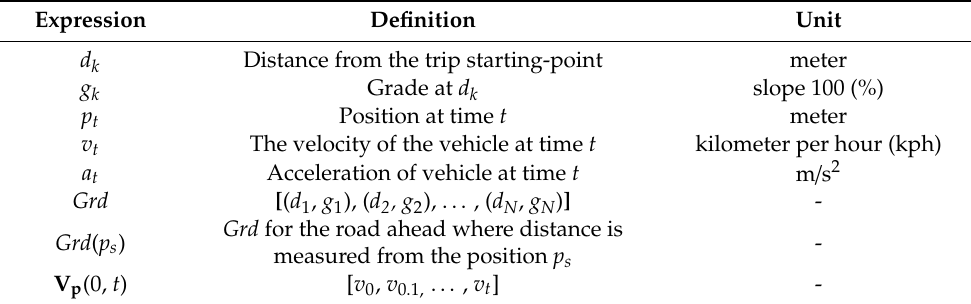
Table 1. Terminologies and definition used in the fuel optimization problem.